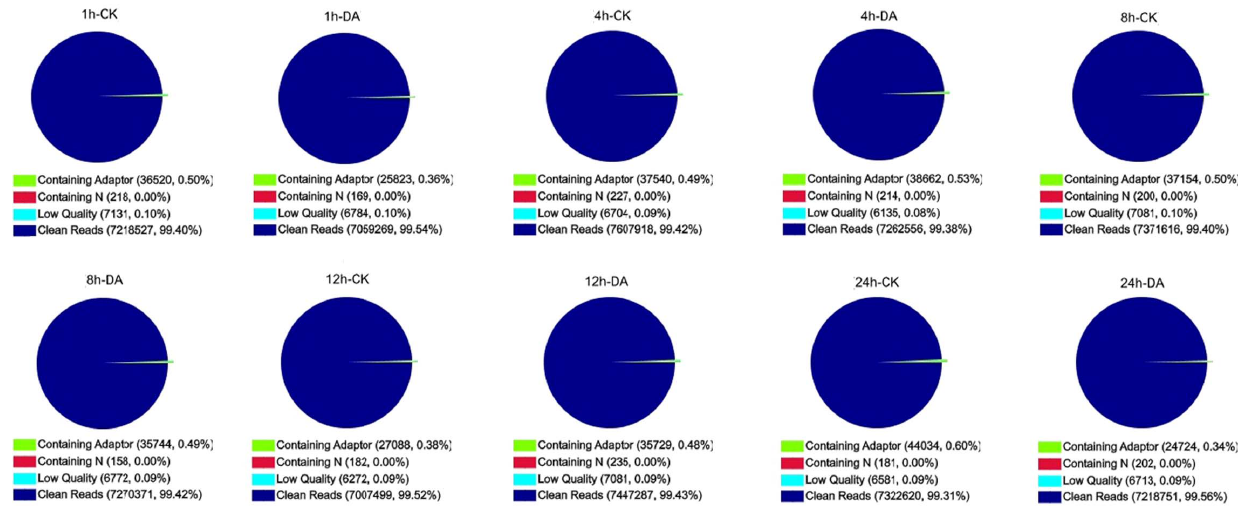
Figure 1. Quality assessment of reads in each library.